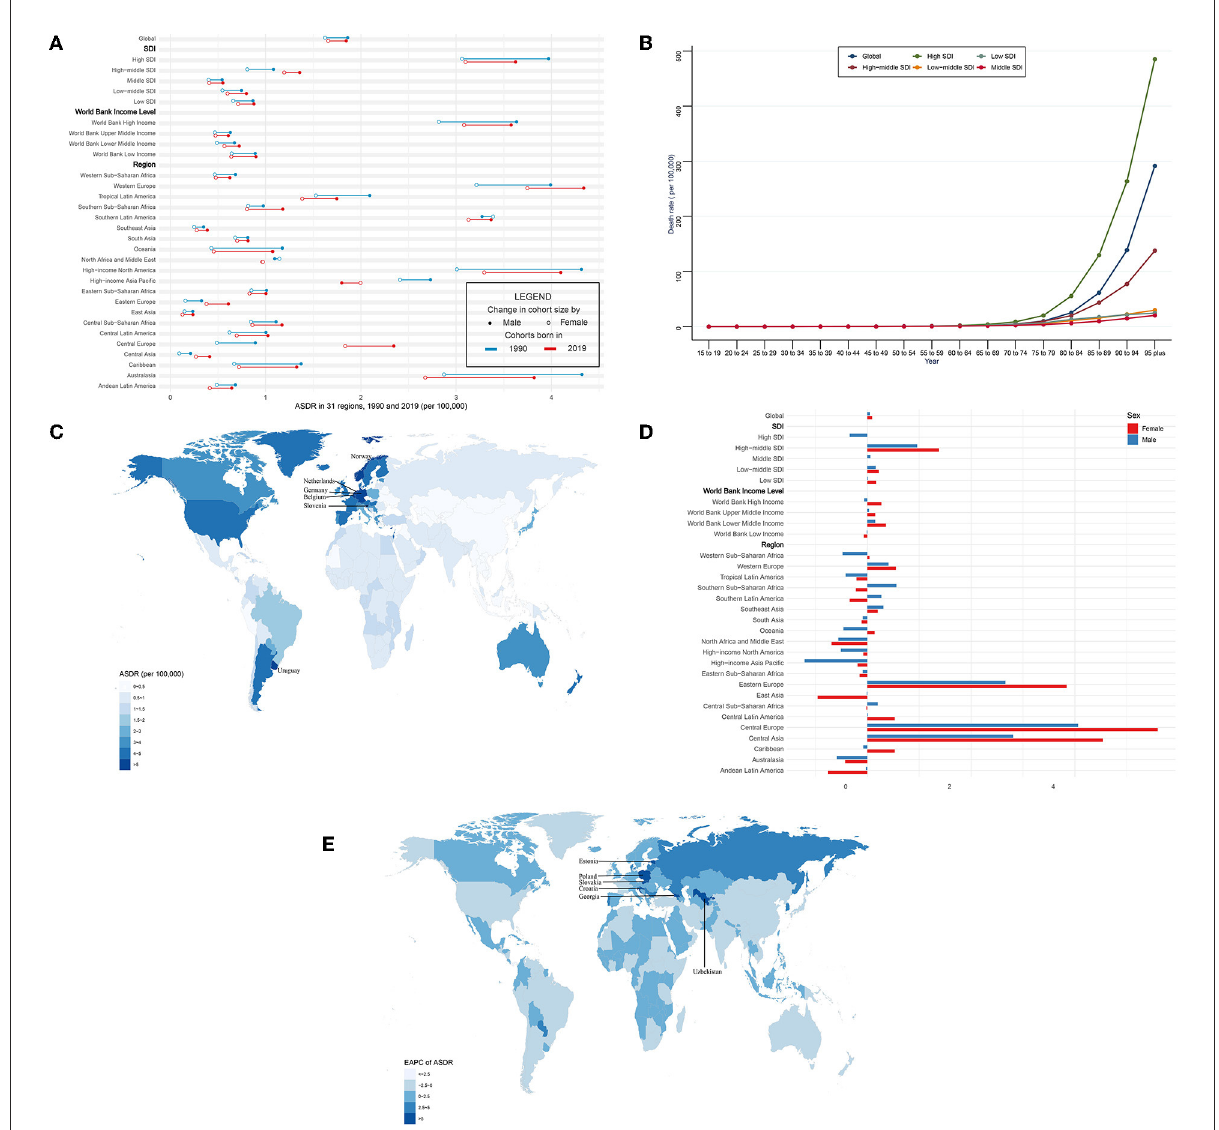
FIGURE3 ASDR and its trend of CAVD. (A) ASDR in 31 regions from 1990 to 2019. (B) Death rate stratified by age in the globe and 5 SDI regions in 2019. (C) ASDR in 204 countries and territories in 2019. (D) EAPC of ASDR in 31 regions from 1990 to 2019. (E) EAPC of ASDR in 204 countries and territories from 1990 to 2019. CAVD, calcific aortic valve disease; ASDR, the age-standardized death rate; SDI, socio-demographic index; EAPC, estimated annual percentage change.